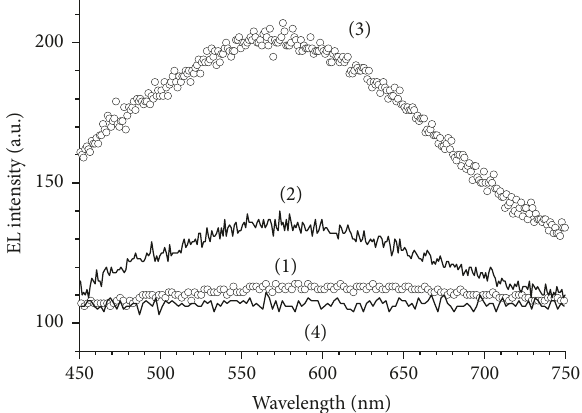
Figure 7: EL spectra of breakdowns measured at reverse bias of 5V (1), 6 V (2), and 9V (3). The spectrum of breakdown free region measure at 9 V is also shown